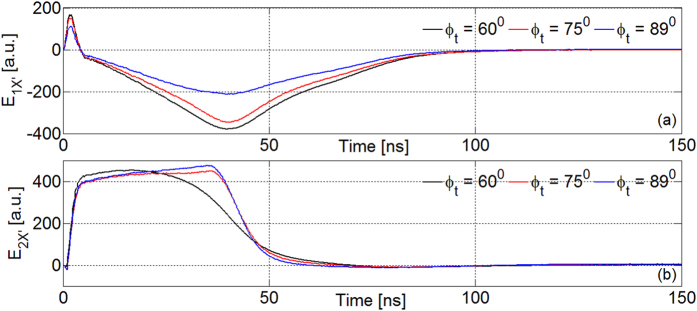
Simulations for E1X′ (a) and E2X′ (b) for different φt.